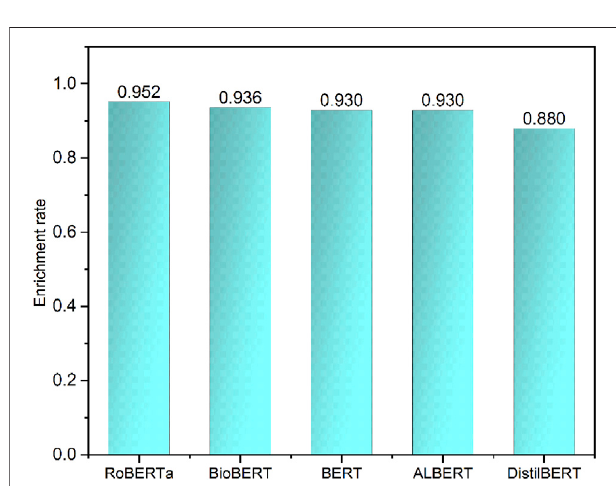
FIGURE 5 | Enrichment rate of fi ne-tuned transformers on Drugbank indication notes.